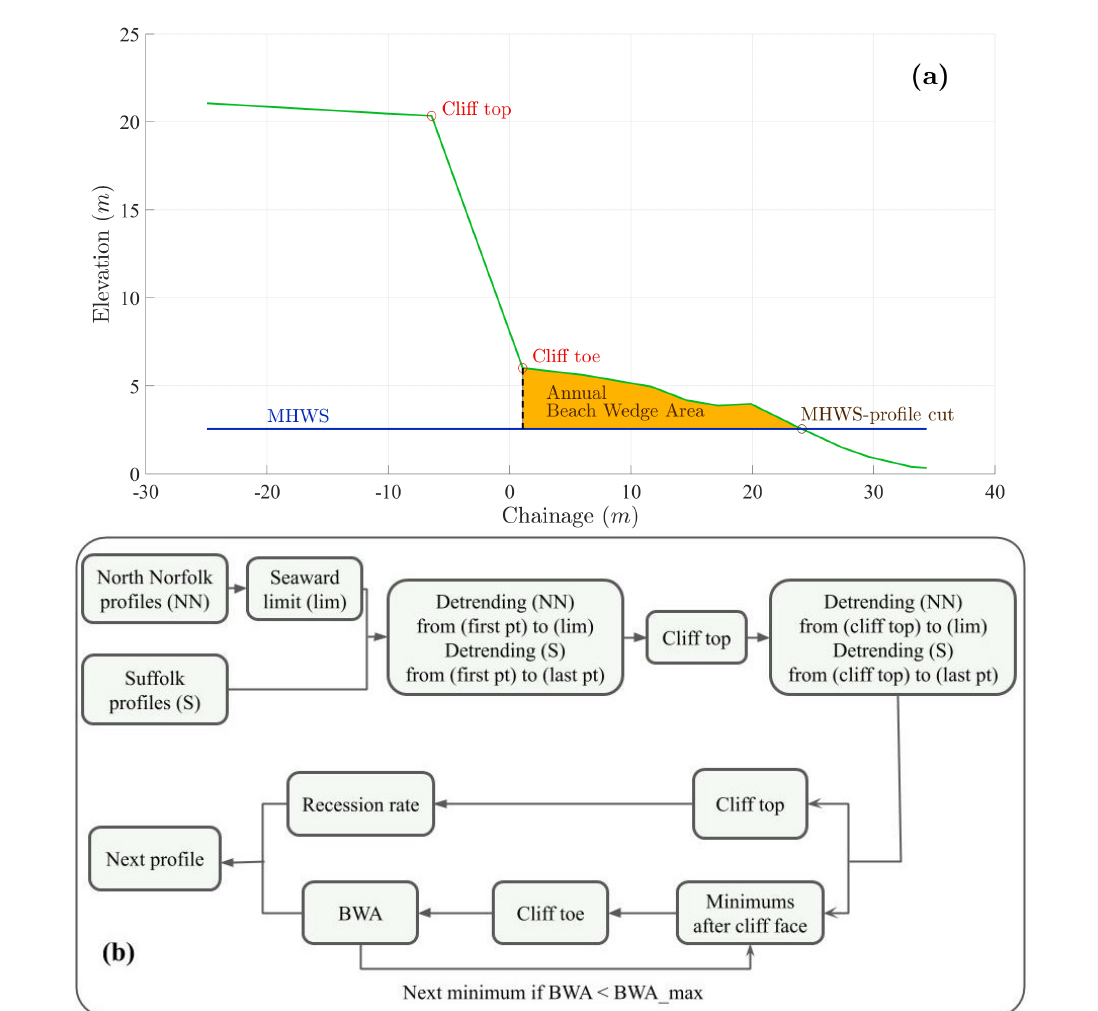
Figure 2. ( a ) Cliff top and toe, Mean High Water Spring (MHWS), MHWS profile cut, and annual beach wedge area. ( b ) Flow diagram